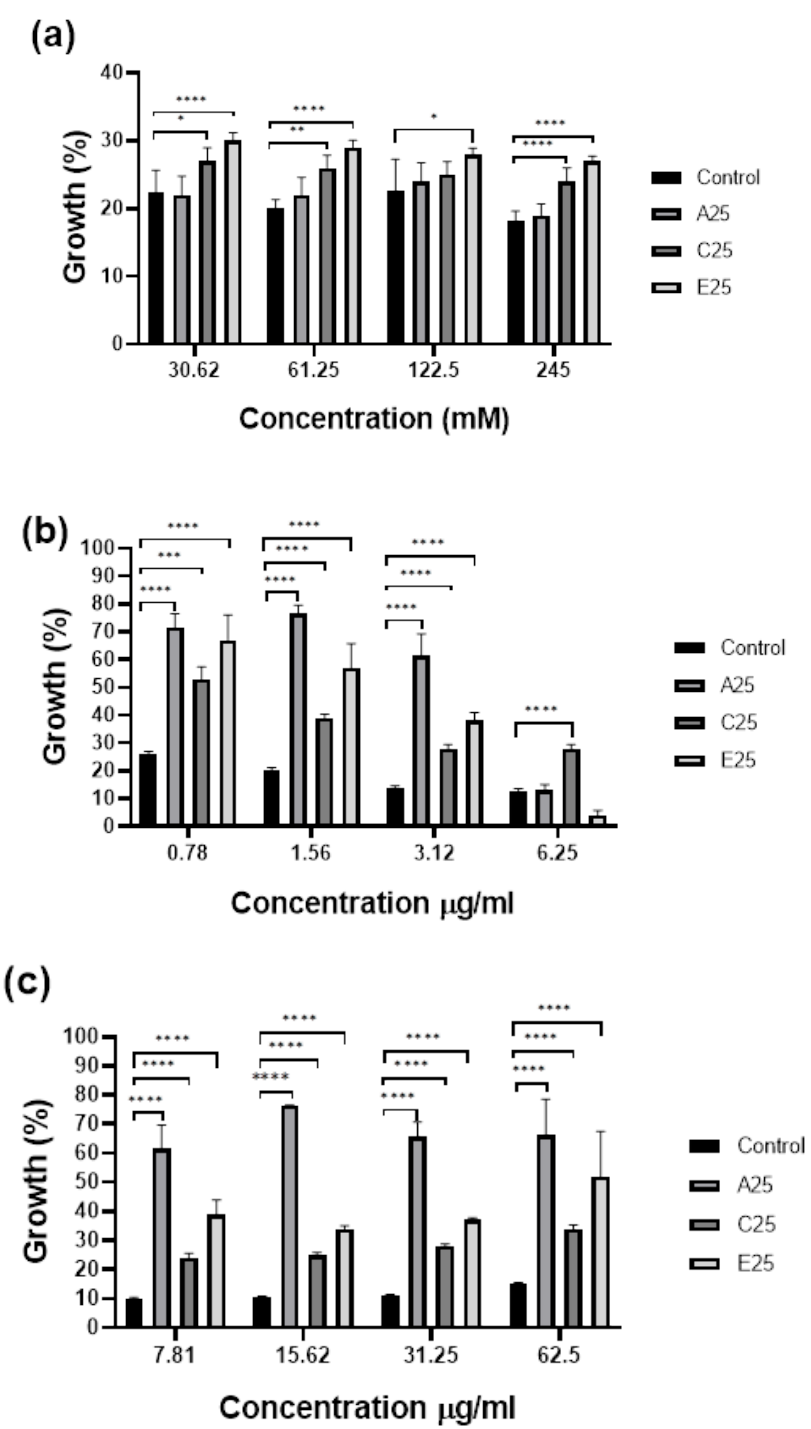
Figure 3. Analysis of the response of control and passaged A. fumigatus conidia to hydrogen peroxide, amphotericin B, and itraconazole. Passaged A. fumigatus conidia demonstrated significantly increased tolerance to ( a ) hydrogen peroxide (strain E25 at concentrations of 490, 122.5, and 61.25 mM (**** p < 0.0001)); ( b ) amphotericin B at concentrations of 3.12–0.78 mg/mL in all of the passaged strains compared to the control (**** p < 0.0001); and ( c ) itraconazole in all of the passaged strains compared to the control with C25 at 56.25 µg/mL (*** p = 0.0017) and all other strains as well as concentrations (**** p < 0.0001) determined by a one-way ANOVA followed by pair-wise multiple comparisons using the Tukey test for each treatment dose (* p = 0.01, ** p = 0.001).